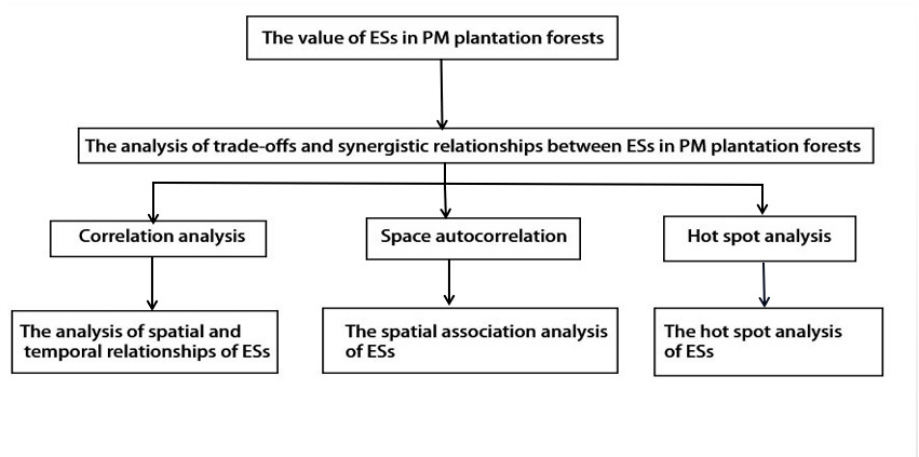
Figure 2. Research framework. Figure 2. Research